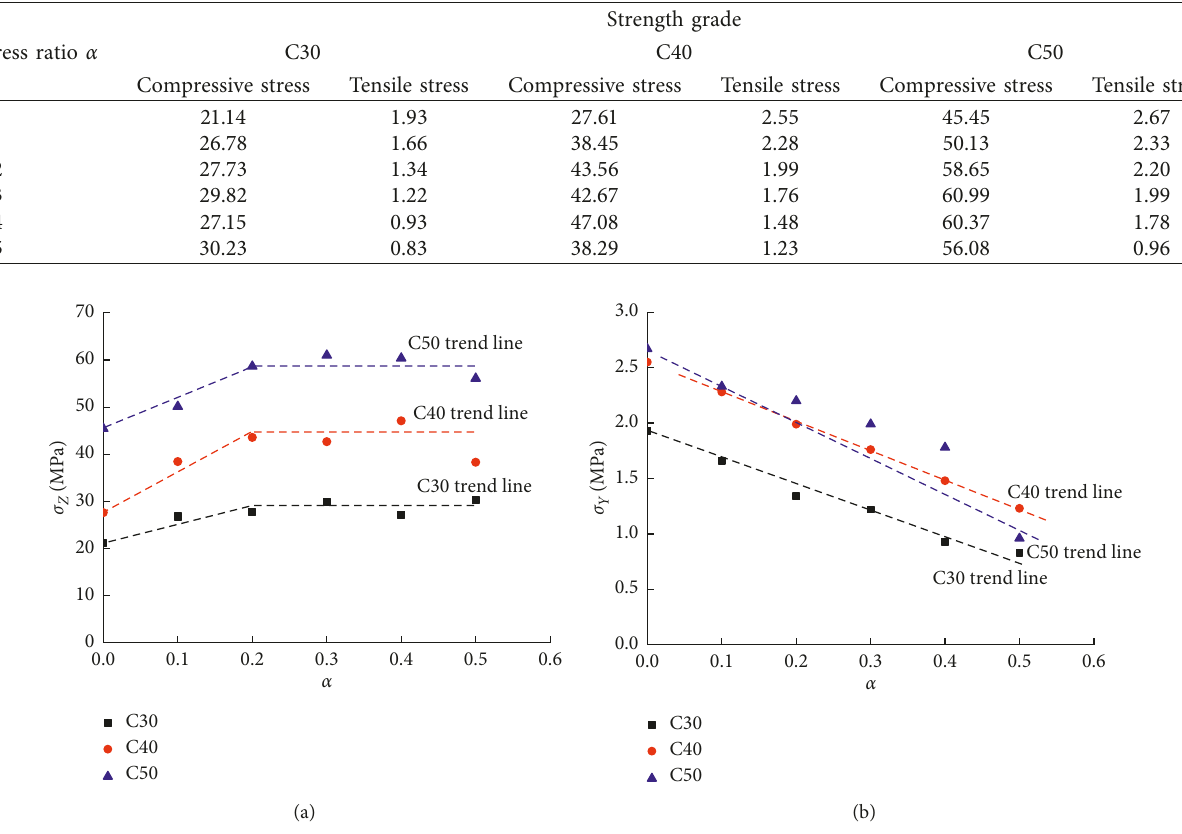
Figure 7: Biaxial loading peak stress of plain concrete. (a) Biaxial compression-compression. (b) Biaxial compression-tension.